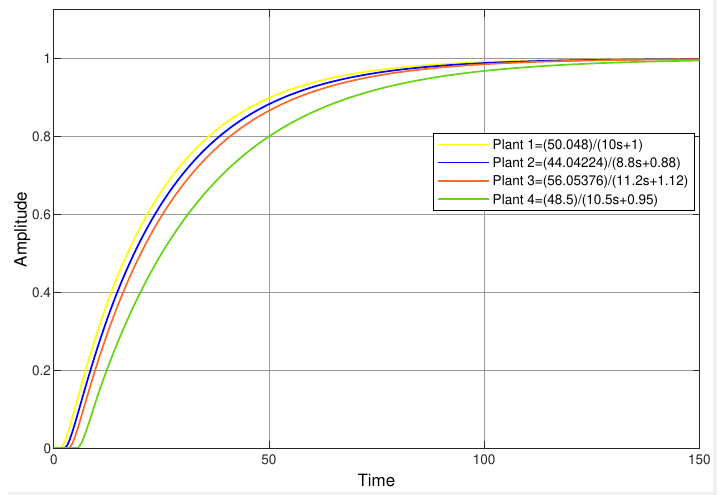
Figure 13. Simulated response of four fixed plants with time-delay using the same